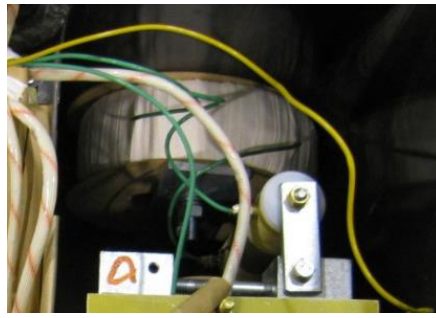
Figure 11. Type of damper.